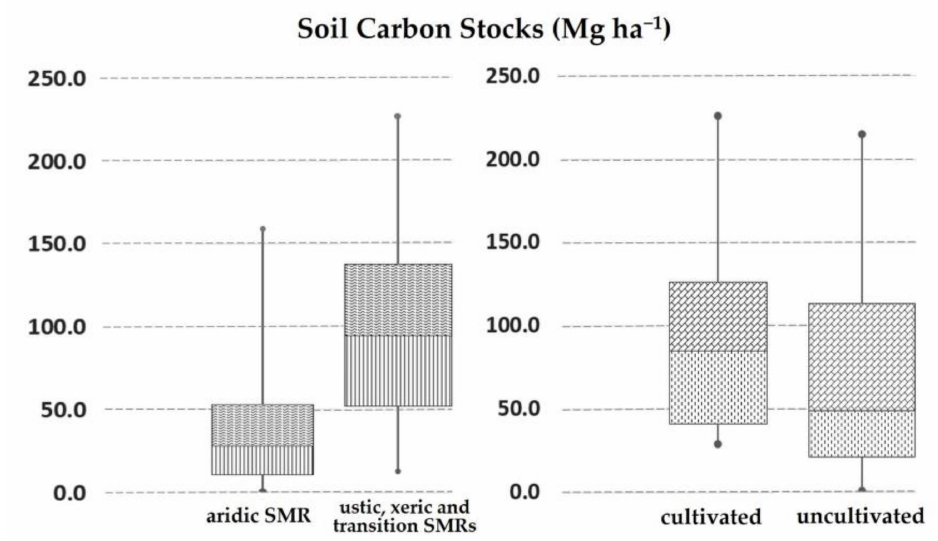
Figure 3. Soil C stocks (Mg ha − 1 ) in studied soil profiles considering: Soil Taxonomy’s moisture regimes ( left ); basic land use: agricultural vs. natural or semi-natural vegetation ( right ). The influences of both factors are reflected in statistically significant differences in both data groups in terms of carbon stocks in the studied soil profiles (Figure